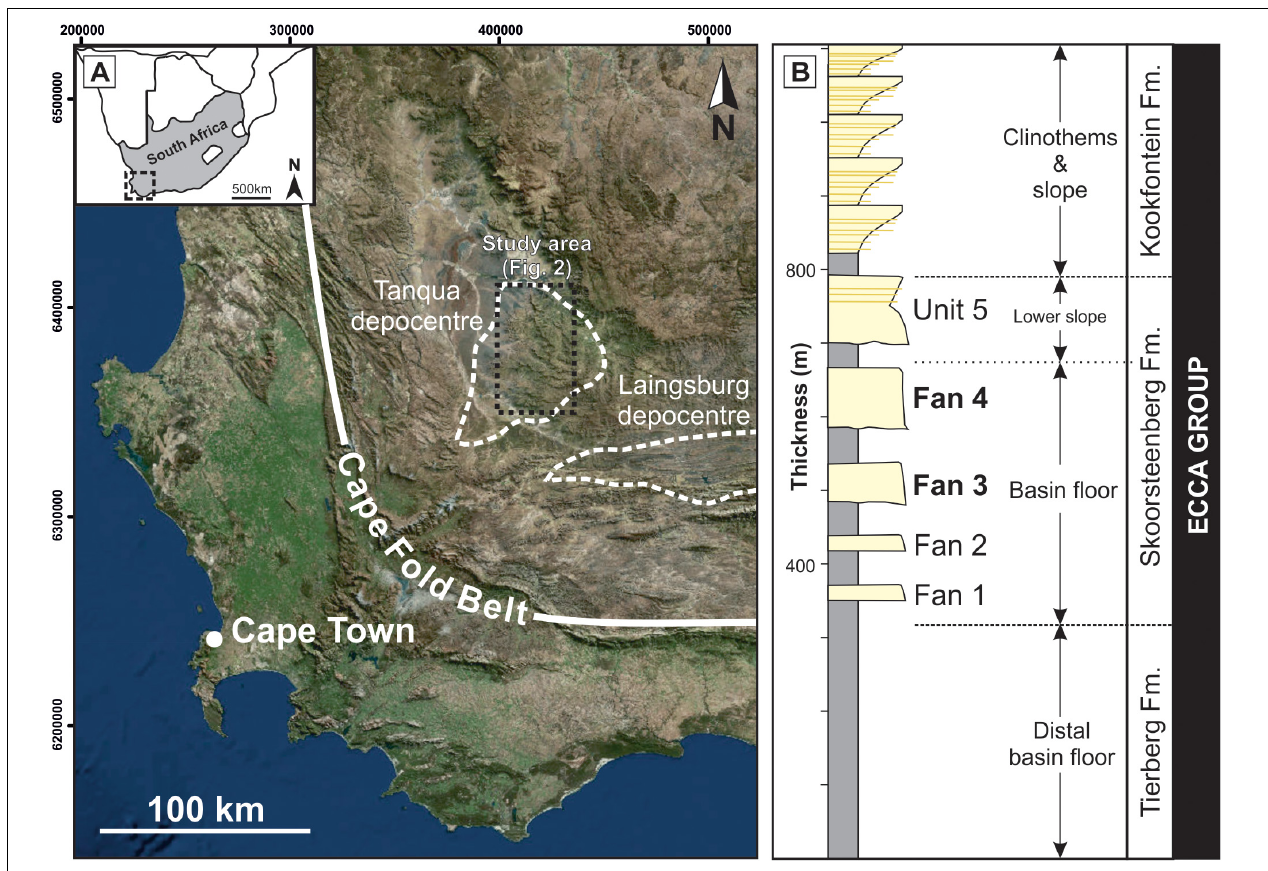
FIGURE 1 | (A) Location map of the Karoo Basin and the Tanqua and Laingsburg depocenters inboard of the Cape Fold Belt. The Tanqua depocenter is the focus of this study. (B) Stratigraphic column of the Tanqua depocenter (redrawn after Prélat et al., 2009; Hofstra et al., 2015). This study focuses on Fans 3 and 4 of the Skoorsteenberg Formation. Image taken from ArcMap: Esri, DigitalGlobe, GeoEye, Earthstar Geographics, CNES/Airbus DS, USDA, USGS, AeroGRID, IGN, and the GIS User